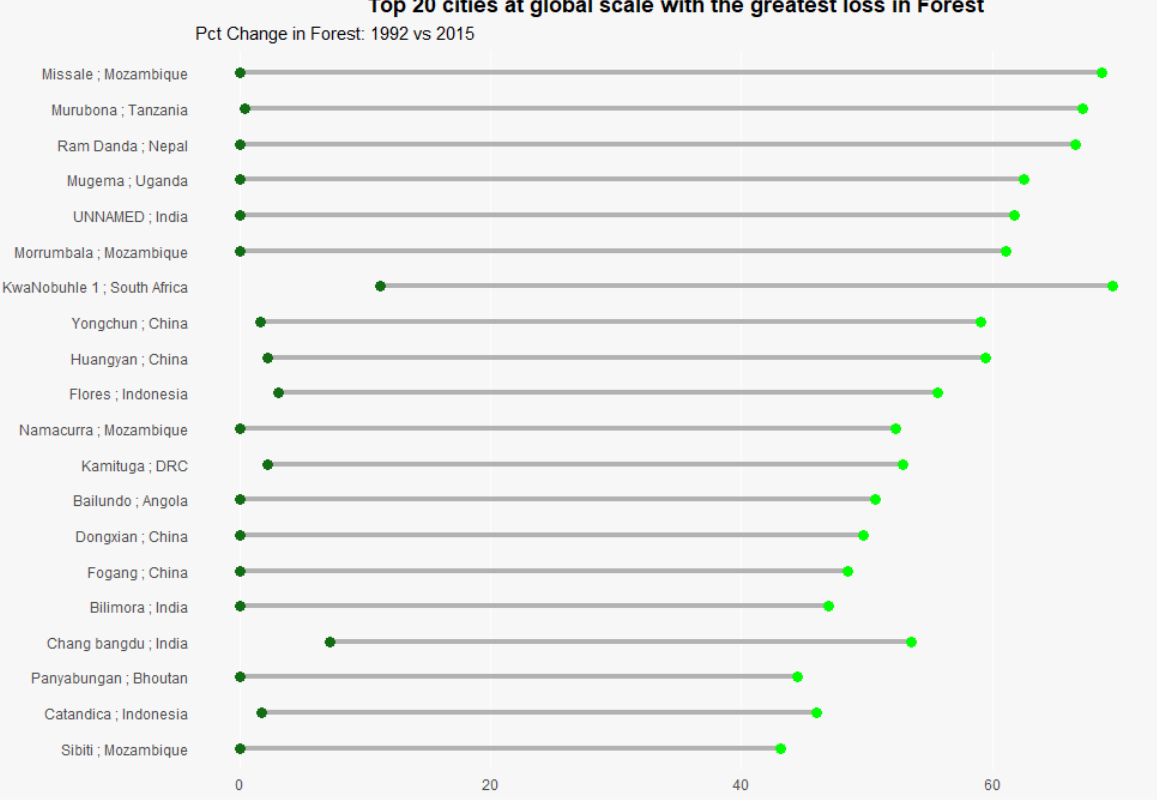
Figure 7. Forest loss due to urbanisation.